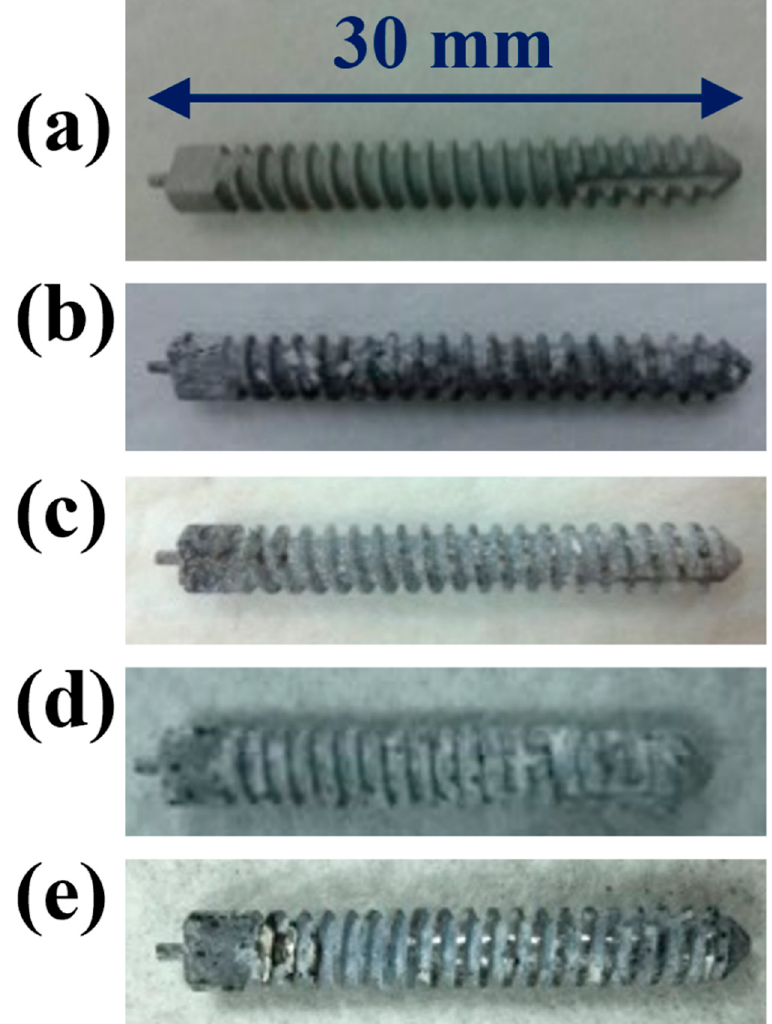
Figure 10. Visual images of the ZK60 Mg alloy bone screw after locking force test: ( a ) SBF non- immersed; ( b ) immersed for 6 weeks; ( c ) immersed for 6 weeks and pulled out of the D3 synthetic bone; ( d ) immersed for 10 weeks; ( e ) immersed for 10 weeks and pulled out of the D3 synthetic bone.